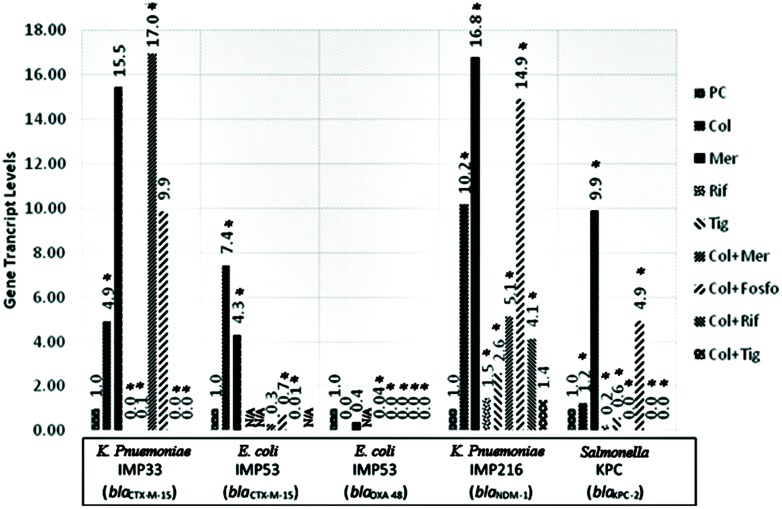
Gene transcript levels in vitro for the genes blaCTX-M-15, blaCTX-M-15 and blaOXA-48, blaNDM-1, blaKPC-2 in their respective isolates IMP33, IMP53, IMP216, and KPC treated with Colistin, Meropenem, Rifampicin, Tigecycline, Colistin+Meropenem, Colistin+Fosfomycin, Colistin+Rifampicin, or Colistin+Tigecycline at the MIC levels. IMP33: colistin: 4.94 (p = 0.025), meropenem: 15.54 (p = 0.376), rifampicin: 0 (p = 0.002), tigecyclin: 0.07 (p = 0.038), colistin and meropenem: 16.95 (p = 0.012), colistin and fosfomycin: 9.87 (p = 0.487), colistin and rifampicin: 0 (p = 0.001), colistin and tigecycline: 0 (p = 0.025). IMP53 (CTX-M-15): colistin: 7.44 (p = 0.042), meropenem: 4.31 (p = 0.026), rifampicin: N/A, tigecyclin: N/A, colistin and meropenem: 0.28 (p = 0.068), colistin and fosfomycin: 0.69 (p = 0.049), colistin and rifampicin: 0.01 (p = 0.037), colistin and tigecycline: N/A. IMP53 (OXA-48): colistin: 0 (p = 0.875), meropenem: 0.36 (p = 0.746), rifampicin: N/A, tigecyclin: 0.04 (p = 0.001), colistin and meropenem: 5.14 (p = 0.041), colistin and fosfomycin: 14.91 (p = 0.002), colistin and rifampicin: 0 (p = 0.045), colistin and tigecycline: 0 (p = 0.001). IMP216: colistin: 10.20 (p = 0.012), meropenem: 16.79 (p = 0.046), rifampicin: 1.47 (p = 0.049), tigecyclin 2.60 (p = 0.002), colistin and meropenem: 5.14 (p = 0.050), colistin and fosfomycin: 14.91 (p = 0.002), colistin and rifampicin: 4.14 (p = 0.002), colistin and tigecycline: 1.38 (p = 0.372). KPC: colistin: 1.23 (p = 0.005), meropenem: 9.89 (p = 0.019), rifampicin 0.23 (p = 0.001), tigecyclin 0.56 (p = 0.043), colistin and meropenem: 0 (p = 0.011), colistin and fosfomycin: 4.93 (p = 0.032), colistin and rifampicin: 0 (p = 0.012), colistin and tigecycline: 0 (p = 0.048). PC, positive control; Col, colistin; Mer, meropenem; Fos, fosfomycin; Rif, rifampicin; and Tig, tigecycline.